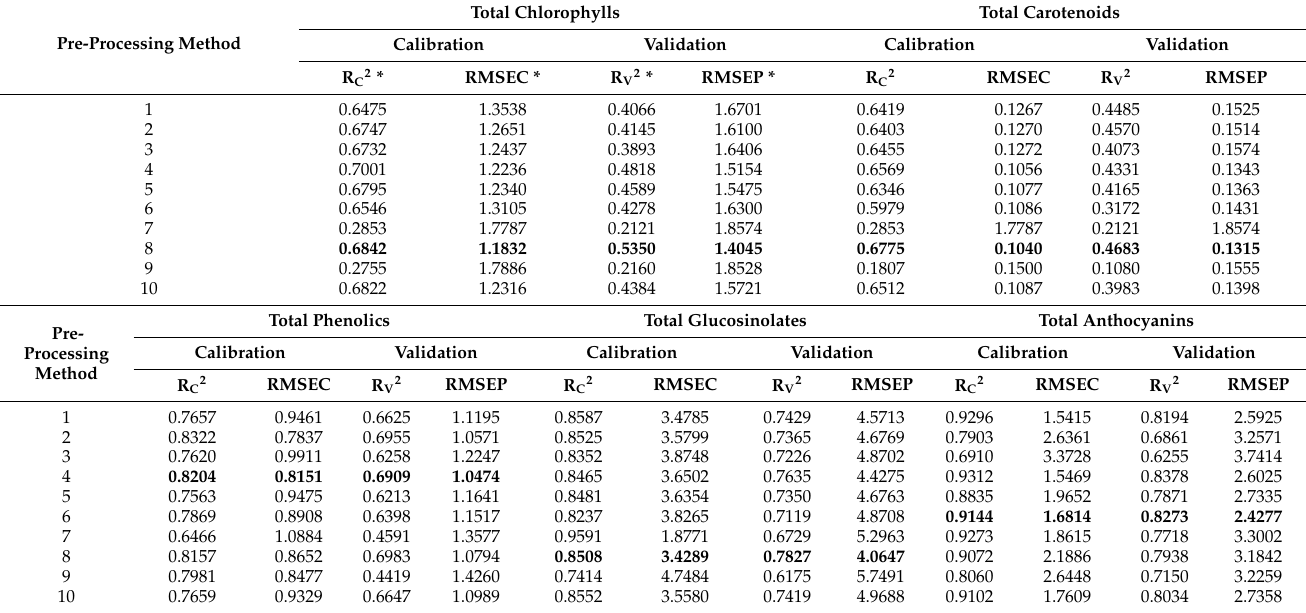
Table 4. PLSR prediction model outcomes on functional components for each pre-processing combi- nation. The prediction model with the best performance among each pre-processing method was determined to have the lowest RMESP values (marked in